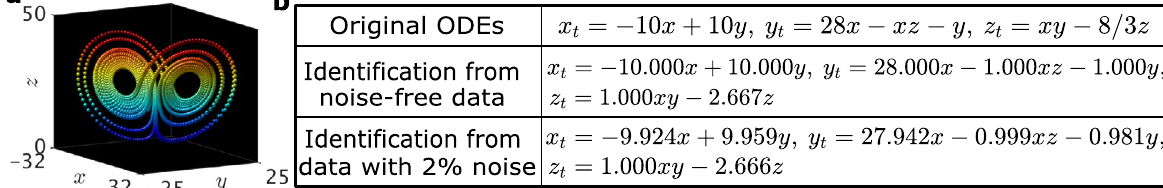
Figure 4. Example for data-driven discovery of ODEs with ATSBL. ( a ) Plot of a numerically 0, 25 integrated trajectory for t with a time step of (cid:31) t ∈ [ ] 8, 8, 27 x 0 , y 0 , z 0 . ( b ) The table shows the original ODEs, i.e., the Lorenz system, and the identified [ ] = [− ] ODEs from noise-free data and data with 2% Gaussian